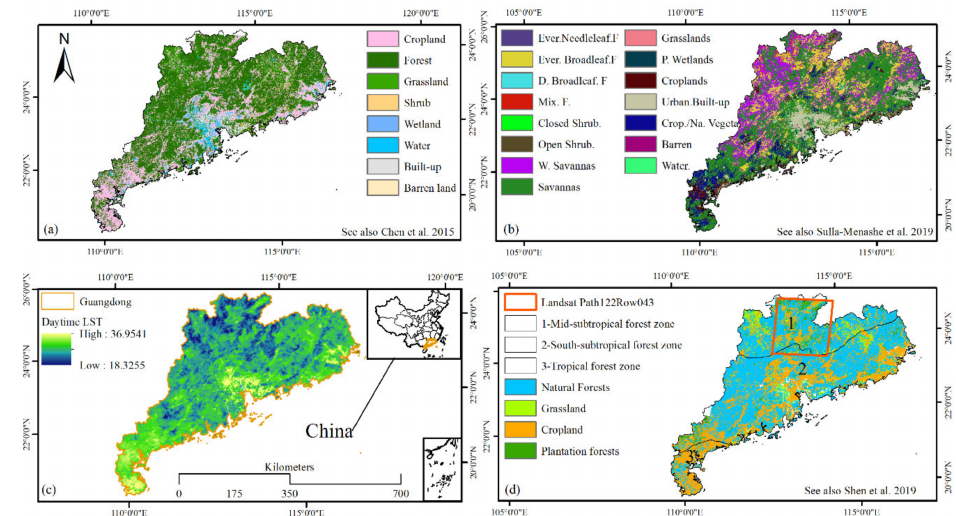
Figure 1. Forest cover data from ( a ) GlobeLand30, ( b ) MCD12Q1, and ( d ) Landsat / PALSAR-based forest / non-forest (FNF) in 2010, as well as ( c ) the average MODIS daytime LST from 2007–2010 in Guangdong, China.